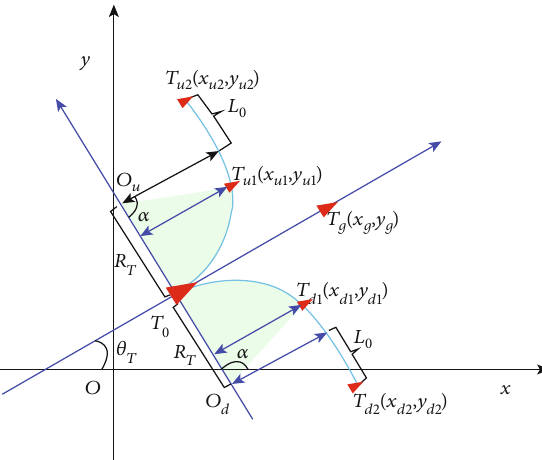
Figure 4: Relative geometrical between target boundary point and initial position of